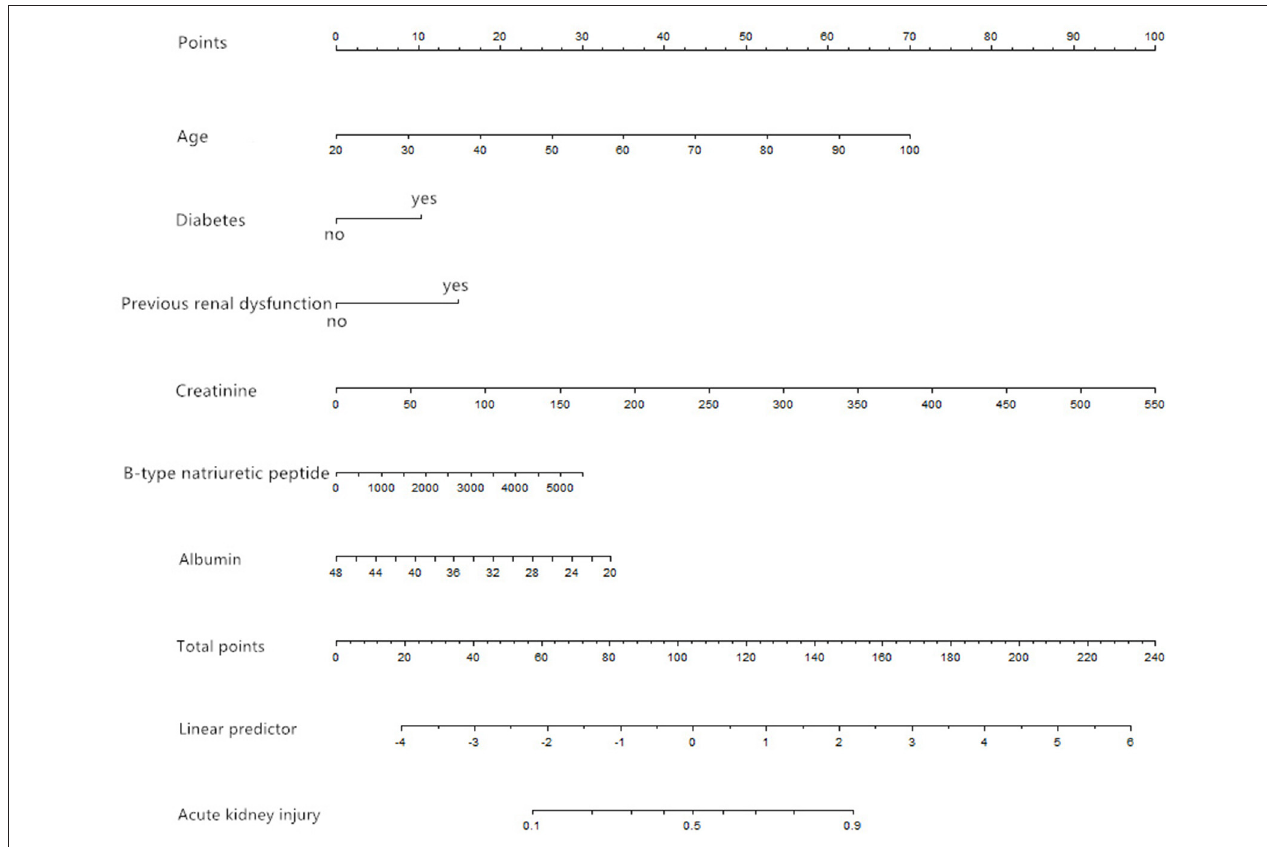
FIGURE 1 | Nomogram based on the results of a logistic regression model (age in units of years, creatinine in units of µ mol/L, B-type natriuretic peptide in units of pg/ml, albumin in units of g/L).